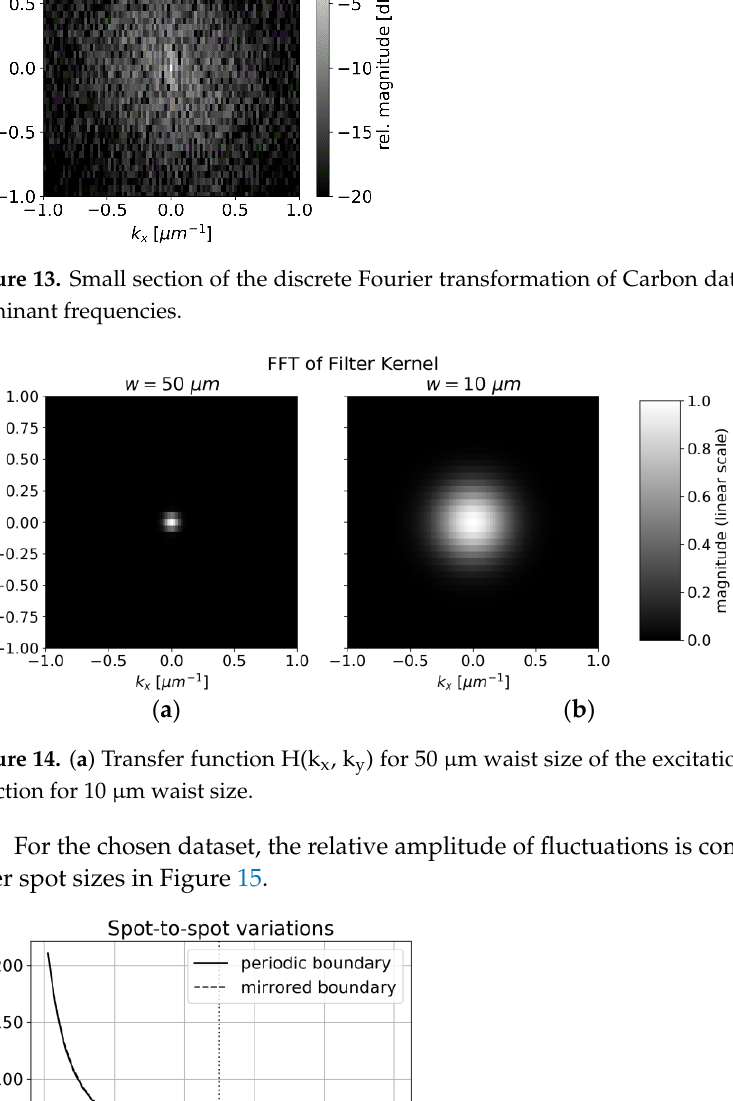
Figure 14. ( a ) Transfer function H(k x , k y ) for 50 µm waist size of the excitation beam. ( b ) Transfer function for 10 µm waist size.